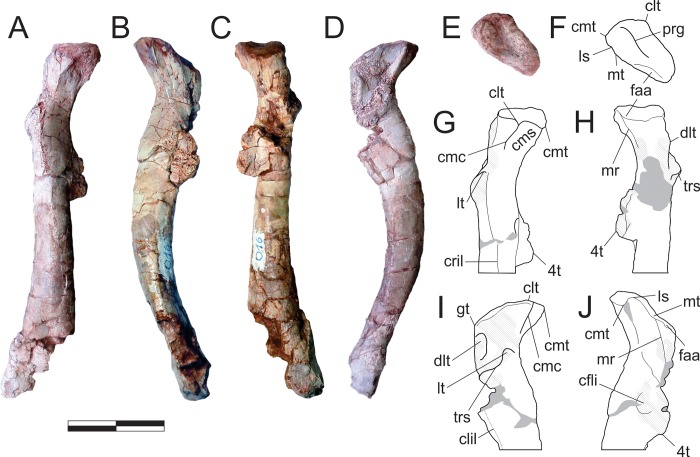
Pampadromaeus barberenai (ULBRA-PVT016), femur.Photographs (A-E) and drawings (F-J) of the right femur in (A,G) cranial, (B,J) medial, (D,H) caudal, (D,I) lateral, and (E-F) proximal views. Abbreviations: 4t, fourth trochanter; cfli, caudofemoralis longus insertion; clil, caudolateral intermuscular line; clt, craniolateral tuber; cmc, craniomedial crest; cms, craniomedial surface; cmt, craniomedial tuber; cril, cranial intermuscular line; dlt, dorsolateral trochanter; faa, facies articularis antitrochanterica; gt, greater trochanter; ls, ligament sulcus; lt, lesser trochantrer; mr, medial ridge; mt, medial tuber; prg, proximal groove; trs, trochanteric shelf. Grey areas indicate parts broken or covered by sediment; hatched areas indicate muscle insertions. Scale bar = 3 cm.